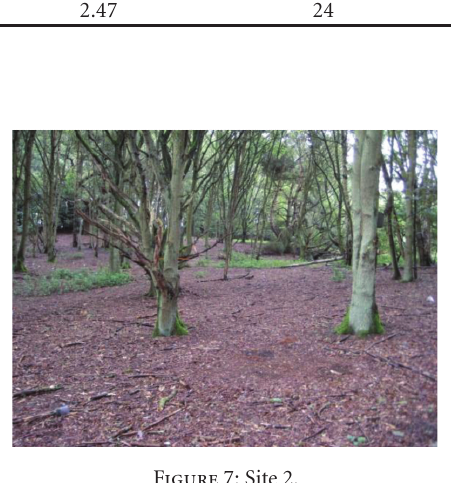
Figure 7: Site 2.